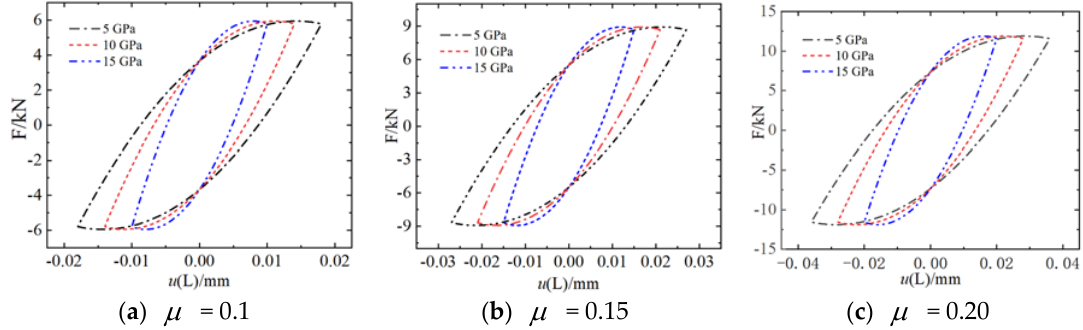
Figure 13. Force ‐ displacement hysteresis curve.